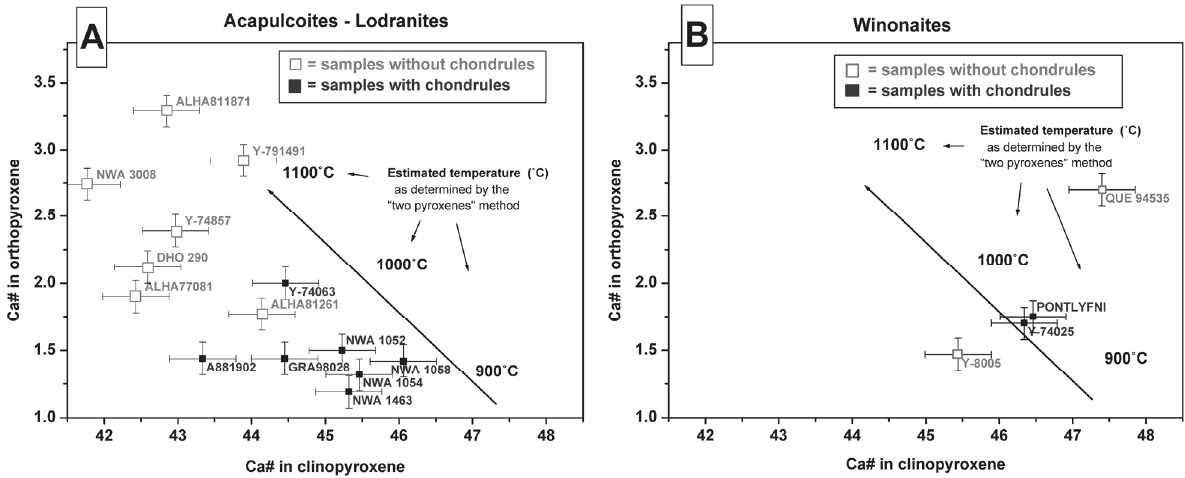
Figure 8. Two pyroxene diagram (Ca content in orthopyroxene as a function of the Ca content in clinopyroxene) for acapulcoites-lodranites ( A ) and winonaites ( B ). Full squares indicate the chondrule-bearing samples, open squares the chondrule-free ones. Superimposed is the line indicating the estimated equilibrium temperature trend as determined by the “two pyroxene”